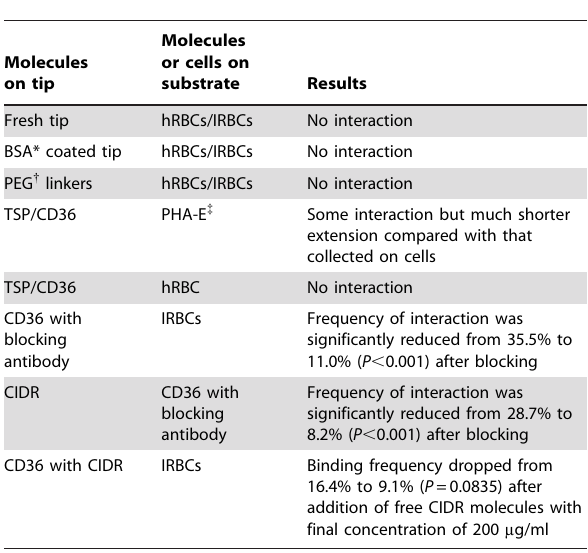
Table 1. Control experiments and results.